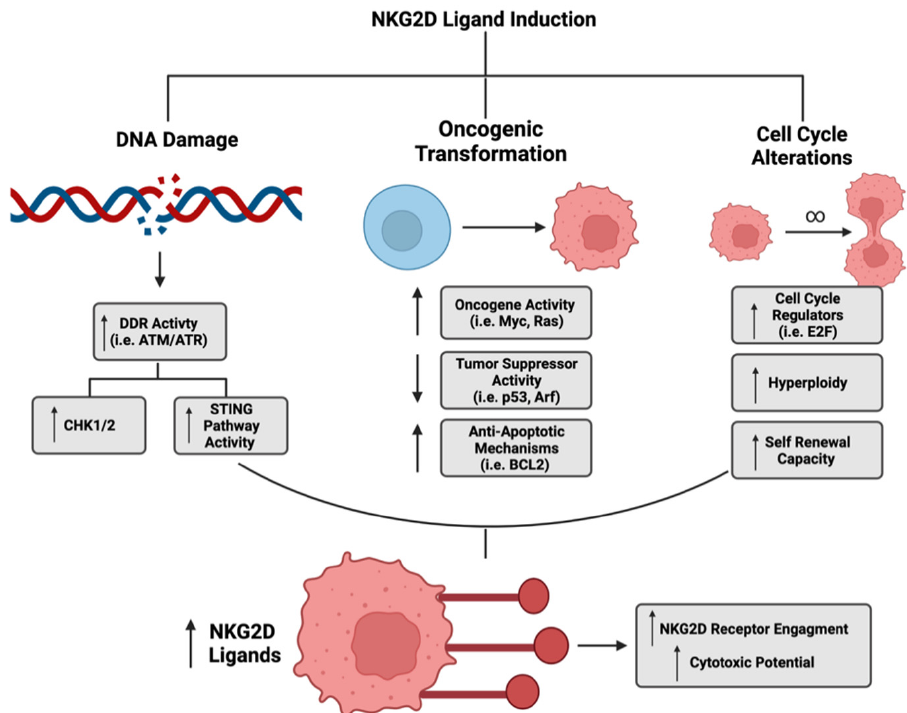
Figure 2. Mechanisms associated with NKG2D ligand induction. Commonly activated pathways associated with cancer progression may influence stress ligand expression. The DNA damage response pathway, which is activated during cancer treatments, increases NKG2D ligand expression via activation of signaling kinases ataxia telangiectasia mutated (ATM) and ataxia telangiectasia and RAD3 related (ATR). ATM/ATR promote the activation of downstream targets that increase and maintain ligand expression. Genetic alterations, such as the oncogenic hits that promote tumorigenesis and behavioral phenotypes, including excessive proliferation and “epithelial-to-mesenchymal” transition, associated with tumor biology are also important regulators of NKG2D ligand expression. Image generated using Biorender.com (accessed on 16 March 2022), licensure certificate available as File S1.